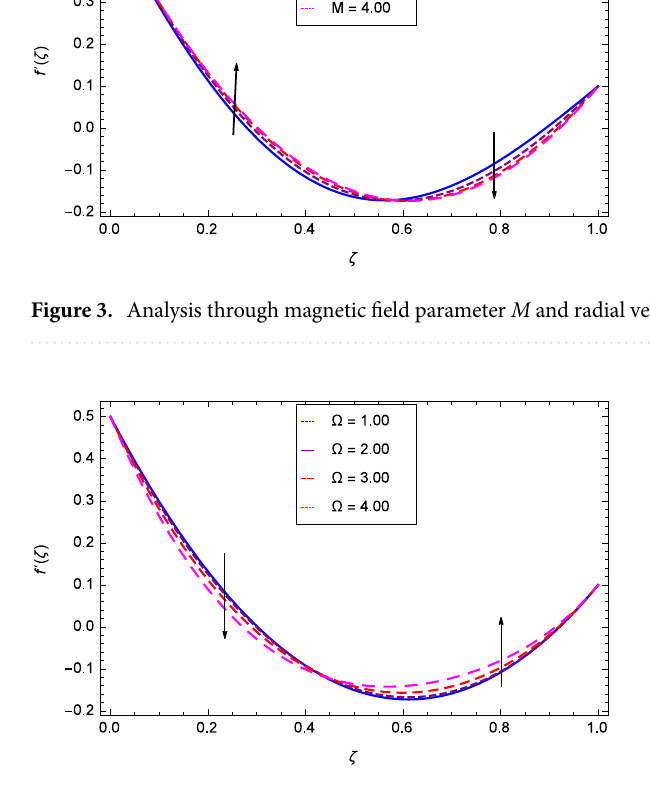
Figure 4. Analysis through rotation parameter (cid:31) and radial velocity f ′ ( ζ ).